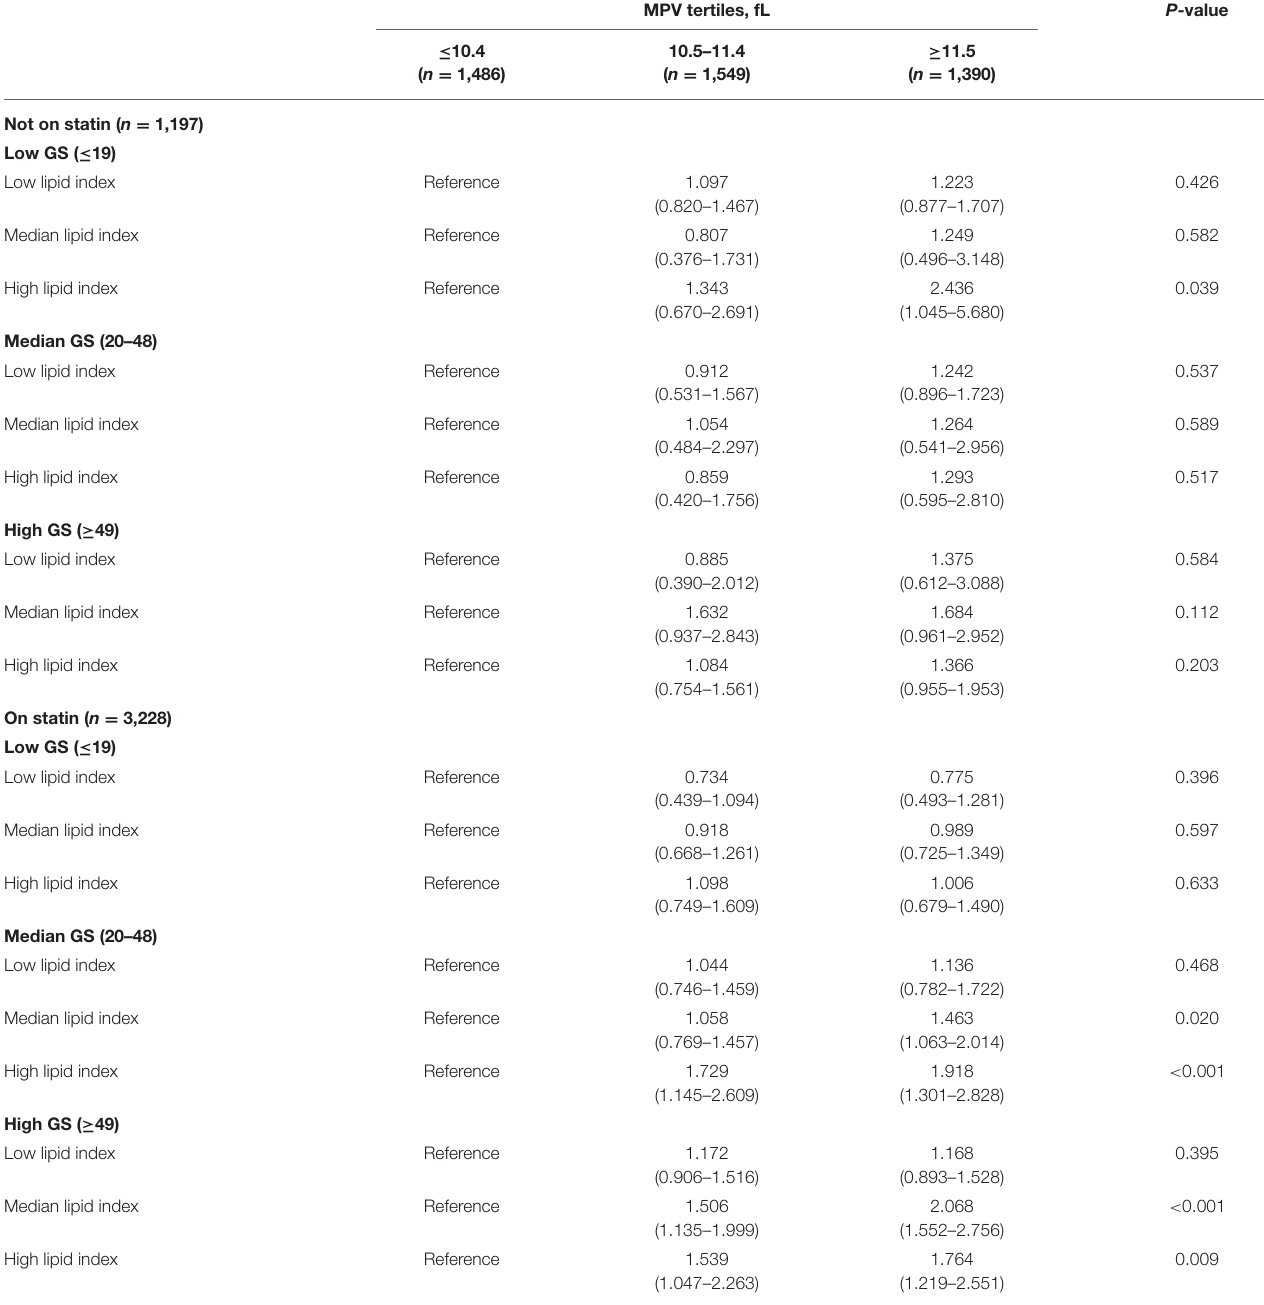
TABLE 6 | Relation between lipid index and GS tertiles by MPV